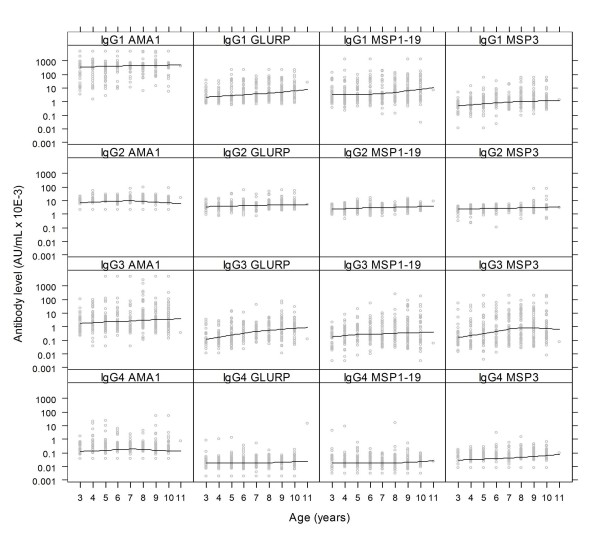
Baseline IgG subclass levels in relation to age. The top, 2nd, 3rd and 4th panels represent IgG subclasses 1 to 4 against AMA1, GLURP, MSP119 and MSP3 in relation to age of Ghanaian children, respectively. The line shows the LOESS smoothed estimate of the geometric mean.